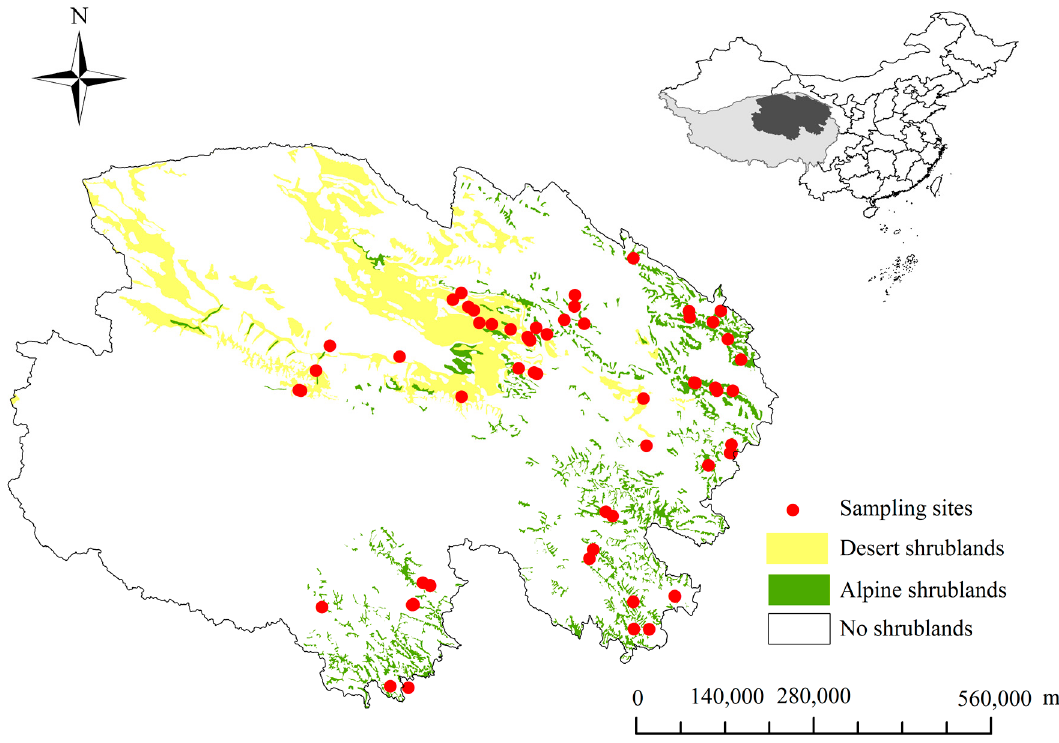
Figure 1. The locations of 65 sampling sites across the Tibetan Plateau shrublands on the background map of China. The distribution is based on a vegetation map of China (1:1,000,000) [38].